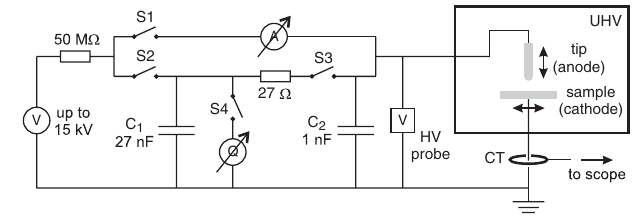
FIG. 1. Schematic drawing of the experimental